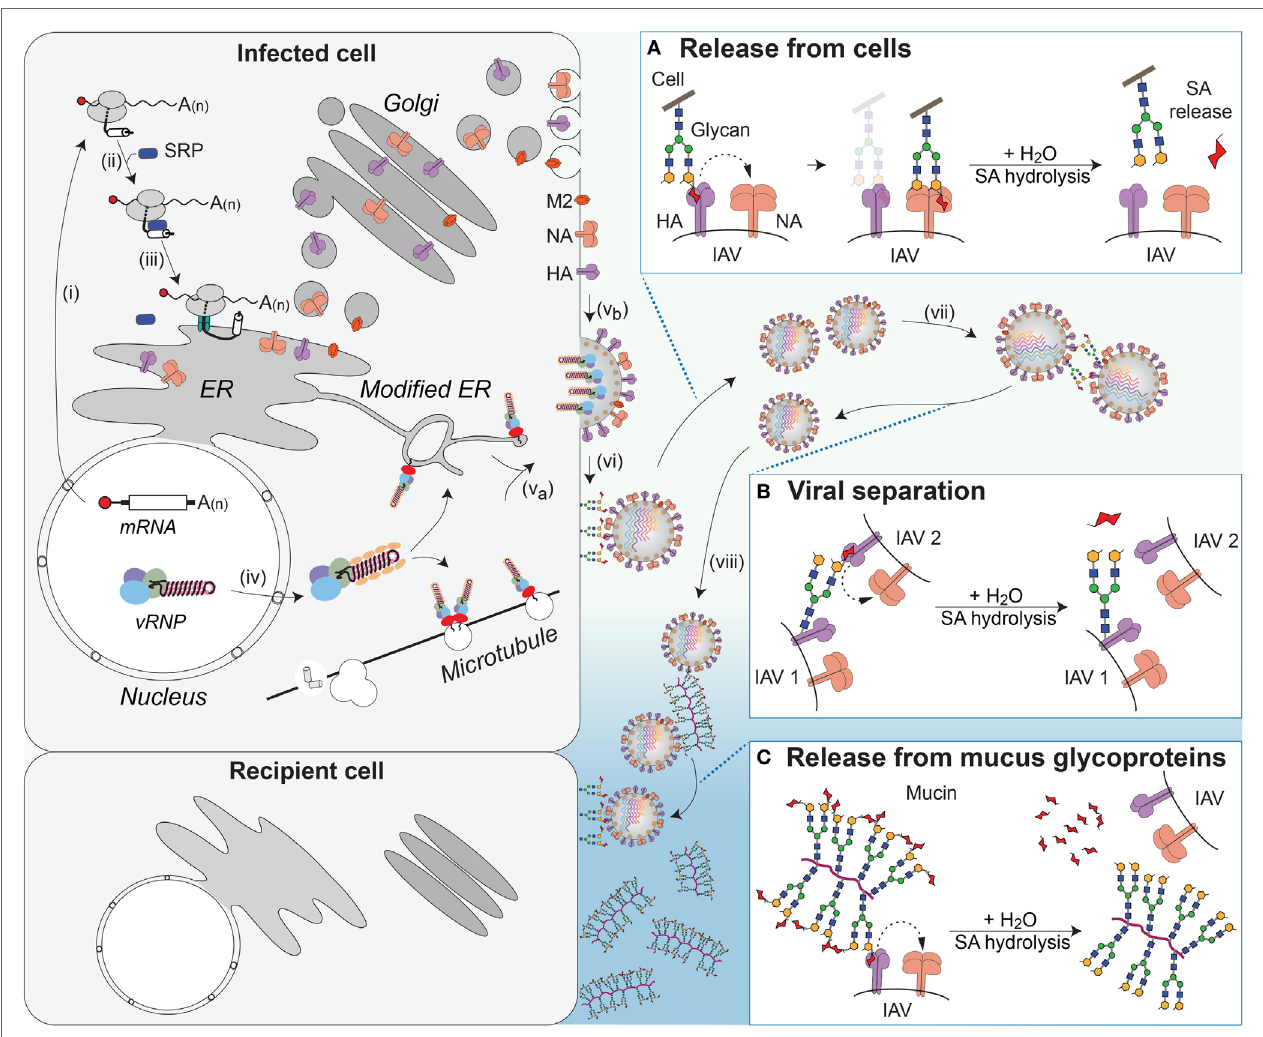
FigURe 6 | NA contributions to viral release and intercellular movement. (i) Viral mRNAs encoding the membrane proteins NA, HA, and M2 are exported for translation by cytosolic ribosomes. (ii) Exposure of the N-terminal signal sequence (HA) or transmembrane domains (NA and M2) recruits the signal recognition particle (SRP), which (iii) targets the ribosome–nascent chain complex for synthesis at the endoplasmic reticulum (ER). Following synthesis, the proteins oligomerize and are trafficked through the Golgi to the plasma membrane. (iv) Late in replication, the viral ribonucleoproteins (vRNPs) are exported from the nucleus and (v a ) trafficked to the budding regions in the plasma membrane, where (v b ) HA and NA have co-localized, with M2 at the budding boundary. (vi) Following budding, progeny virus can remain associated with the infected cell’s surface through HA binding to sialic acid (SA). (Box A) The envelope protein NA promotes release of the virus from the infected cell surface by hydrolyzing the glycosidic bond attaching the SAs. (vii) SAs present on the glycans of HA and NA can result in HA-mediated virus–virus association. (Box B) NA can separate the viruses by removing these SAs. (viii) In the respiratory tract, the epithelium is protected by mucus, rich in sialylated glycoproteins such as mucin, which can associate with HA and slow viral movement. (Box C) NA can cleave off the SAs from the glycoproteins within the mucus to facilitate movement of the virus to neighboring